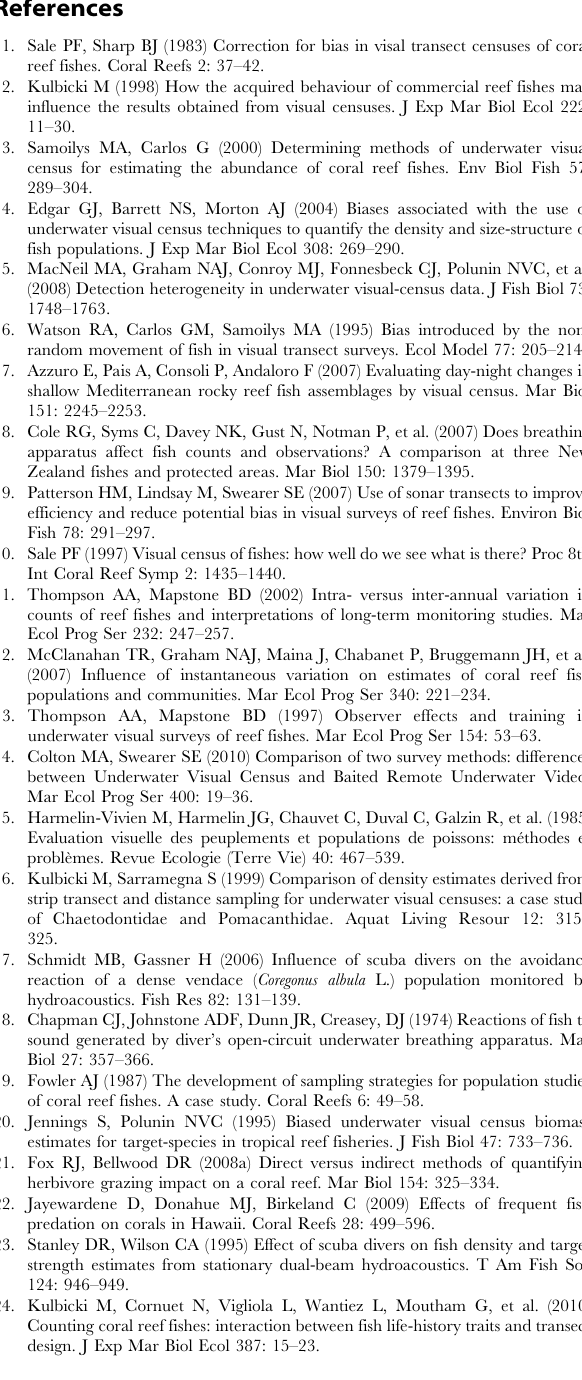
Table S2 Tukey’s HSD post-hoc test showing signifi- cance between different UVC techniques. All 3 transects (fixed distance, tape (immediate return) and tape (after 5 minutes)) differ significantly from one another (values marked in bold). Table S3 One-way ANOVA for overall fish abundance and UVC techniques. Significant values are marked in bold. Text S1 Sources used in literature